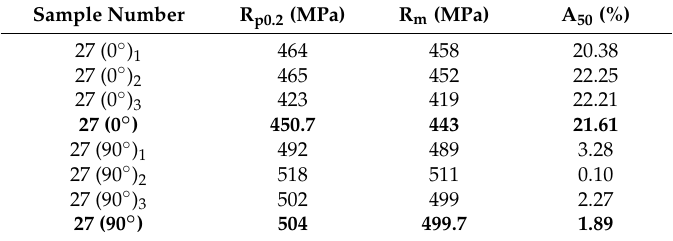
Table 2. Mechanical properties of material identified by uniaxial tensile test (test specimen No. 27): R p0.2 : alternative yield point; R m : tensile strengt; A 50 : elongation at fracture; the bold represents average value.